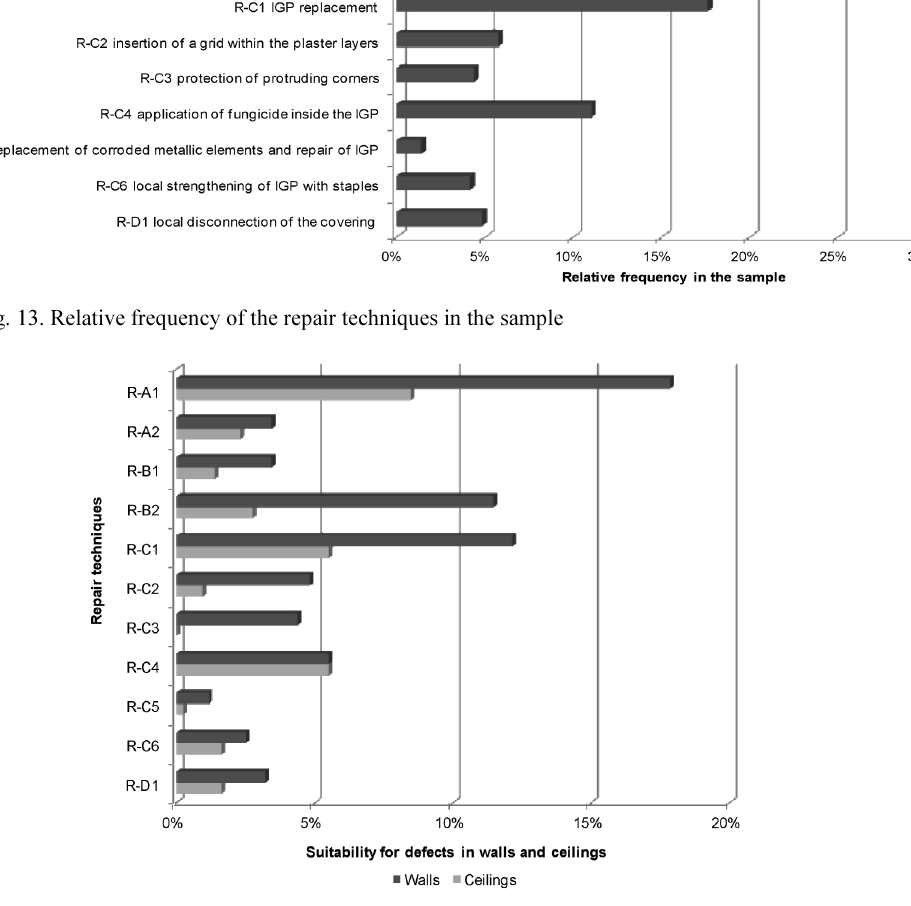
Fig. 14. Suitability of each repair technique for defects in walls and